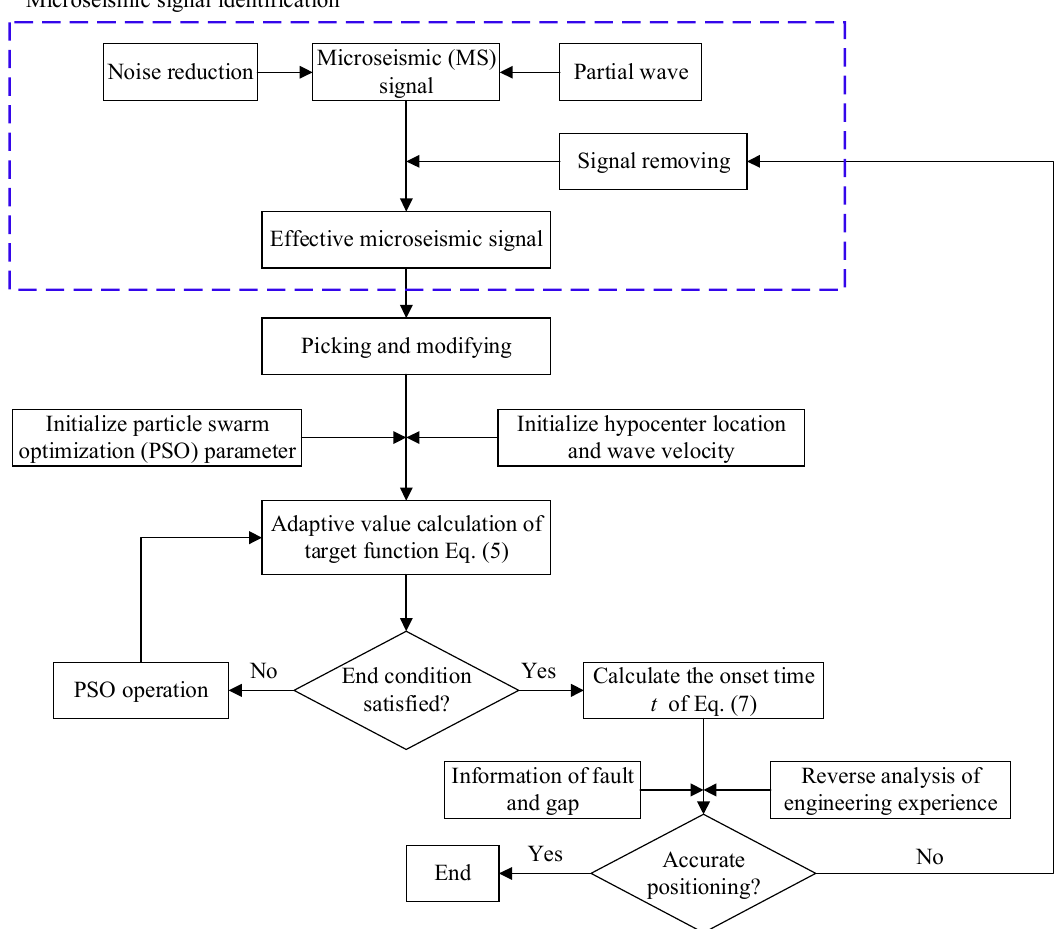
Figure 2. Flowchart of microseismic (MS) source location algorithm with hierarchical strategy based on particle swarm optimization (PSO).